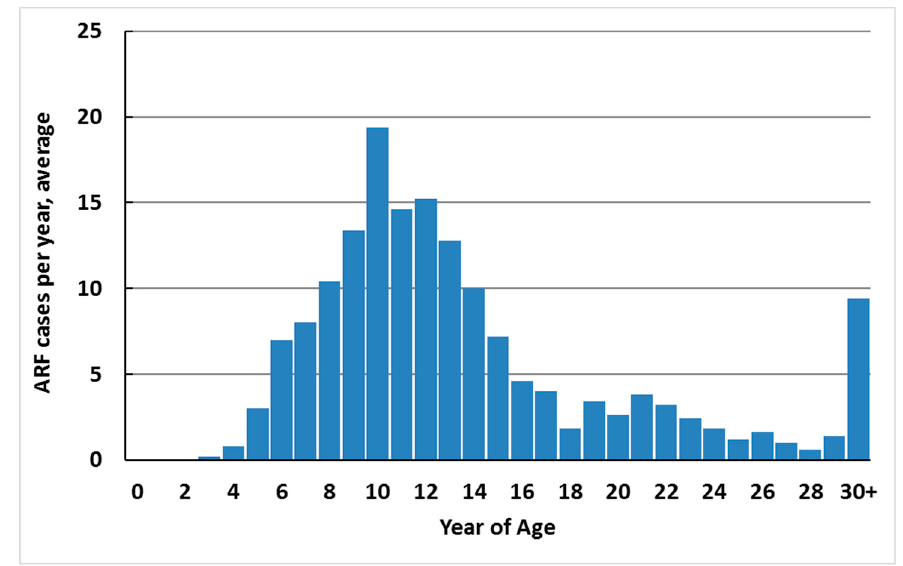
Figure 4. ARF incidence by single year of age, average annual initial hospitalisation number, 2010–2014. A small but significant majority of cases were male (56.7% during the 2010–2014